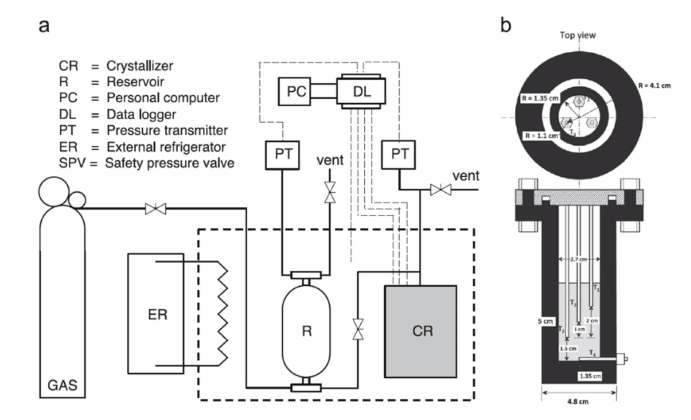
Figure 1. Schematic diagram of gas hydrate apparatus; ( a ) schematic diagram, ( b ) cross-section of a crystallizer